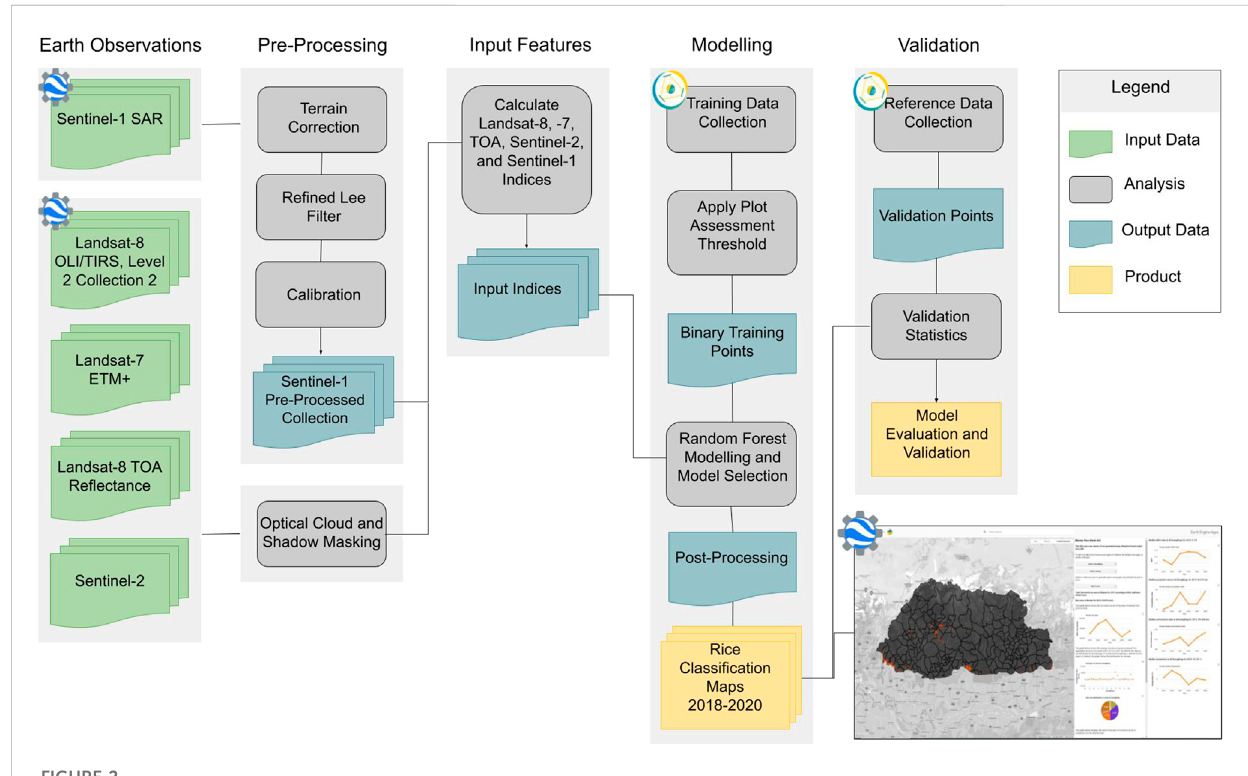
FIGURE 2 Agricultural classi fi cation and estimation service (ACES) work fl ow.